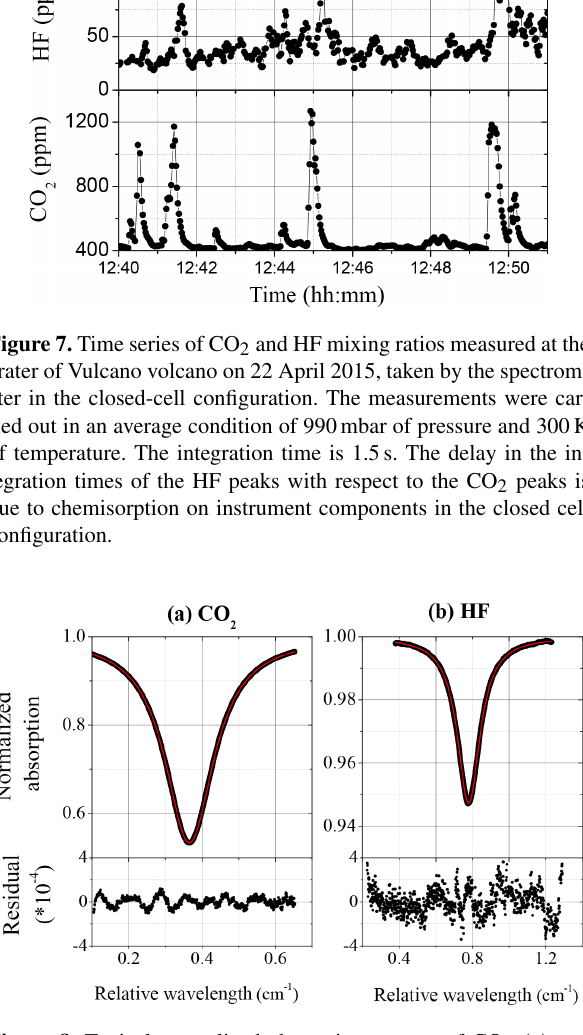
Figure 8. Typical normalized absorption spectra of CO 2 (a) and HF (b) detected in proximity to a fumarole of the Vulcano volcano on 20 May 2015 and Voigt fit results (red line). The residuals of the fitting procedure are shown in the bottom plots. The CO 2 mixing ratio is 2350ppm and the HF mixing ratio is 4.5ppm. The integra- tion time is 2s. The measurement was carried out at a pressure of 990mbar and at a temperature of